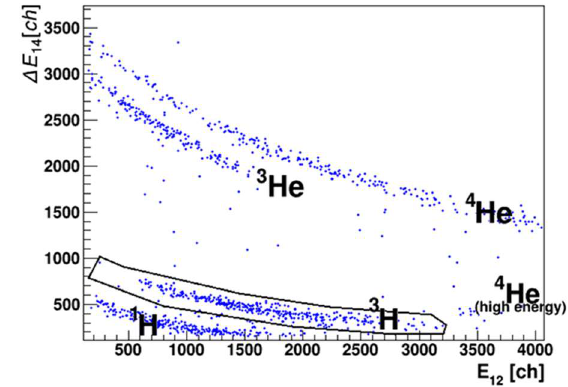
Fig. 3. A typical ΔE – E spectrum for a ΔE strip correlated with a single E pad of the OSCAR telescope. One can see the loci of protons, tritons, 3 He and 4 He while, the selection of tritons is depicted with the solid black line.